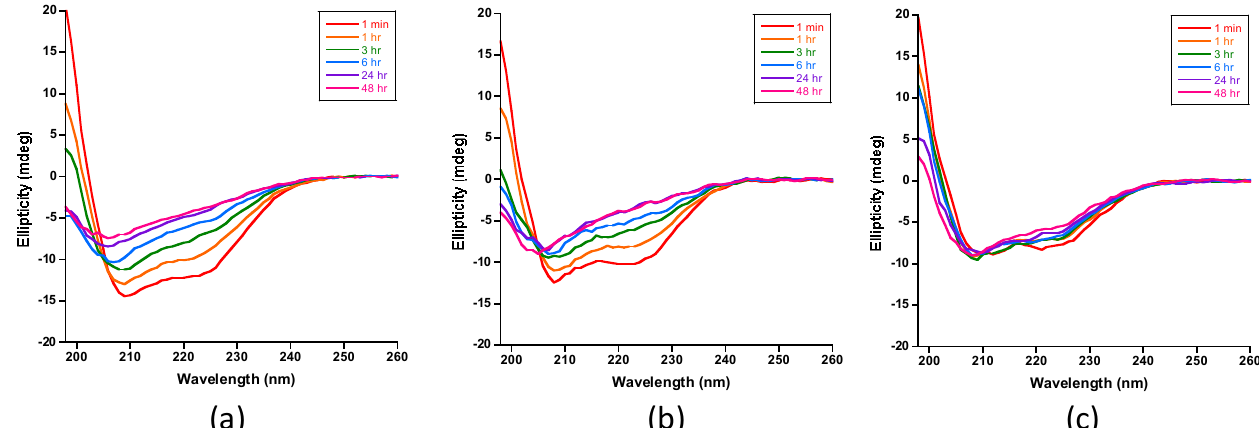
Figure 4. CD spectra of IDE-dependent degradation of insulin in the absence and presence of polyphenols at 37 ◦ C. ( a ) Spectra recorded for insulin digests that do not contain polyphenols (control samples) show the progressive loss on insulin’s helical CD signals at 222, 208, and 198 nm, consistent with the loss of α -helical structure. ( b ) Spectra recorded for insulin digests in the presence of resveratrol were similar to the spectra recorded for the control samples, indicating that the polyphenol had no effect on IDE’s activity toward insulin. ( c ) Spectra recorded for insulin digests in the presence of EGCG showed that the helical signals of insulin persist, indicating that EGCG inhibits insulin proteolysis by IDE. The insulin concentration in all samples was set at 20 μ M in 50 mM Tris buffer (pH 7.4). The substrate-to-enzyme molar ratio and the polyphenol-to-insulin molar ratio were set to 100:1 and 2:1, respectively. All samples were kept at 37 ◦ C in between spectral acquisition.